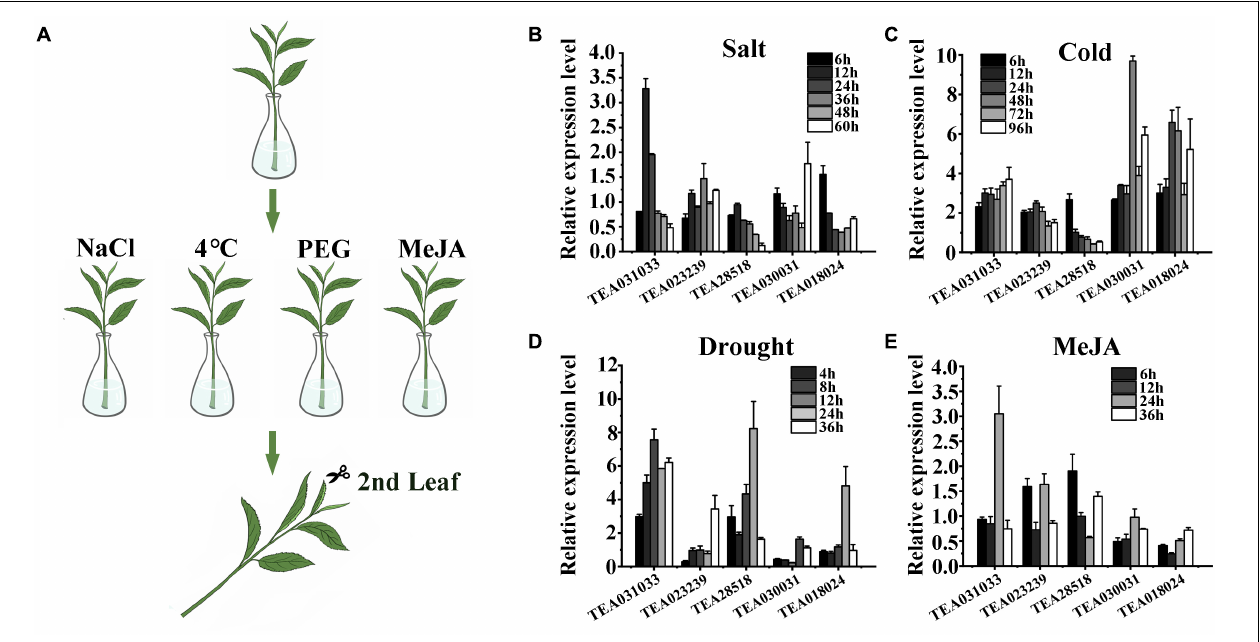
FIGURE 3 | Validation of transcriptomic data by quantitative real-time analysis. (A) Schematic of four stress treatments on branches of the tea plant. (B–E) Quantitative real-time analysis data of five selected genes subjected to four